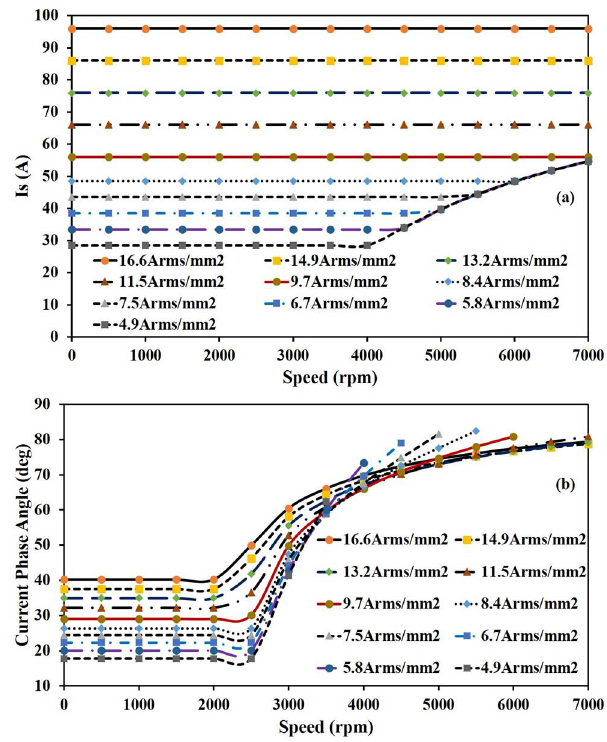
Figure 9. ( a ) Current and ( b ) current angle variation of IPMSM with speed.